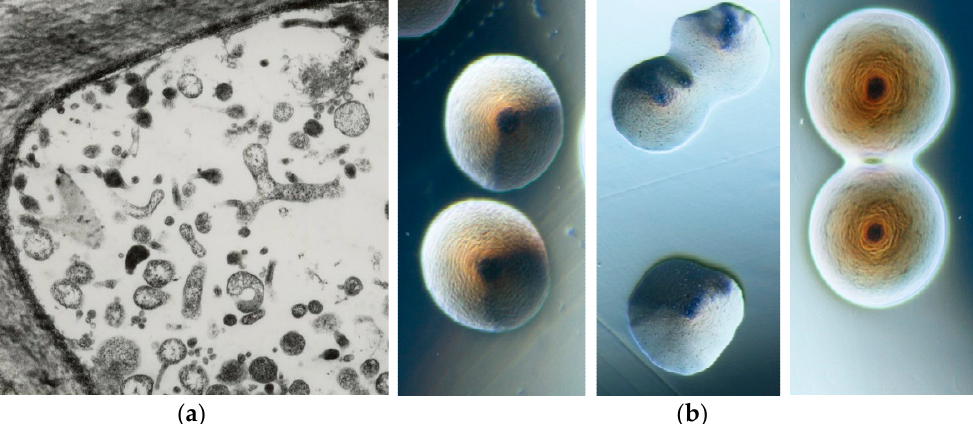
Figure 2. Transmission electron microscopy picture of a thin section in the phloematic tissue of a phytoplasma infected gladiolus plant showing the presence of strong pleomorphism (× 8000) ( a ). Tree morphotypes of colonies containing phytoplasmas under binocular microscope (× 40) ( b ).